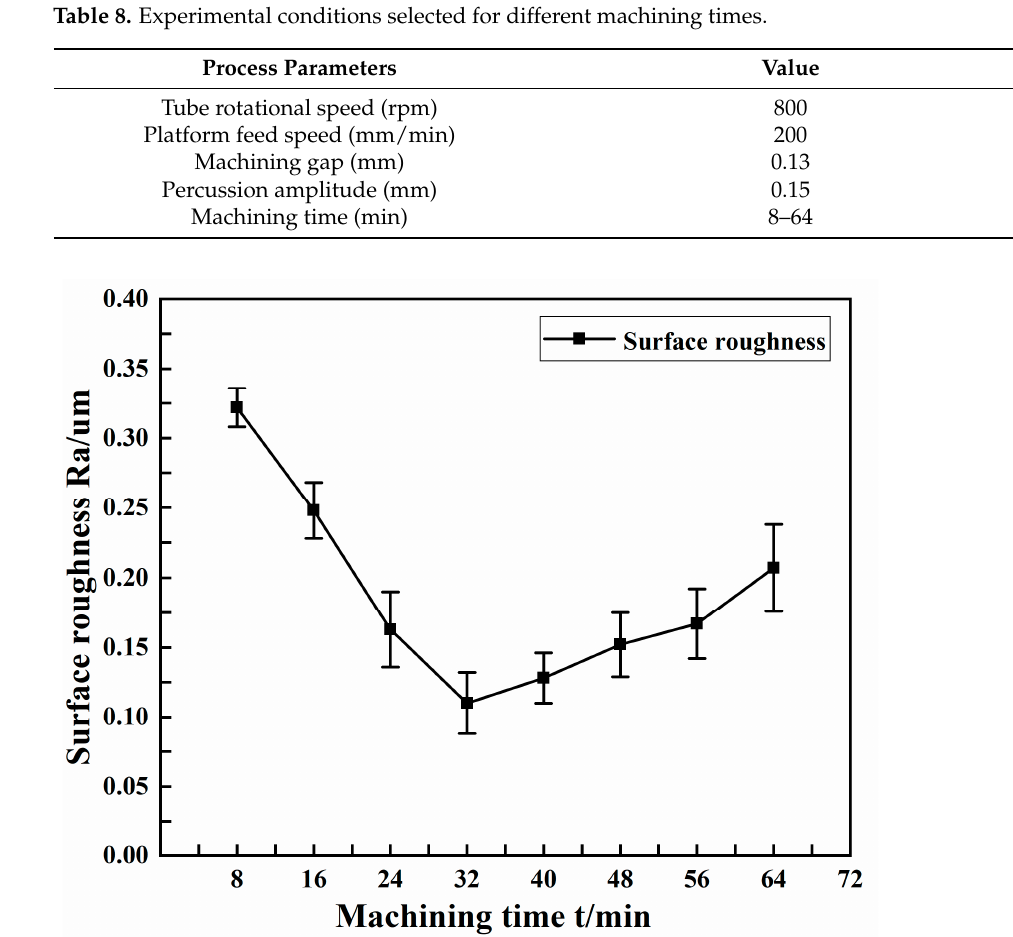
Figure 12. Effect of machining time on surface